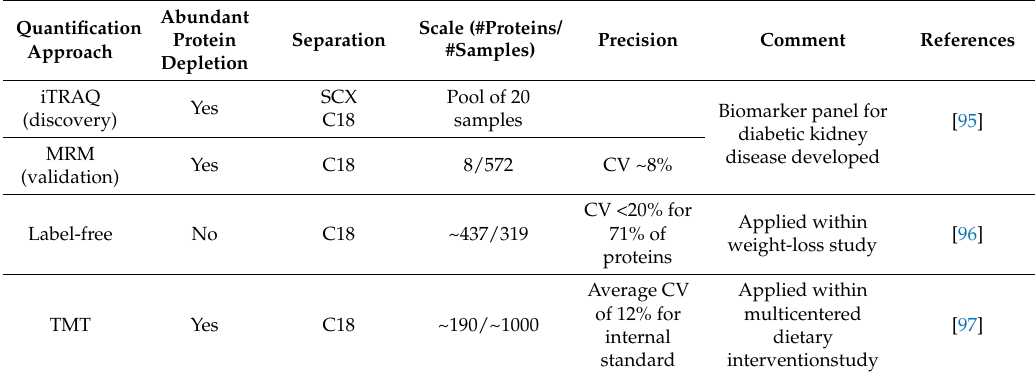
Table 1. Recently published LC-MS/MS-based protein biomarker identification